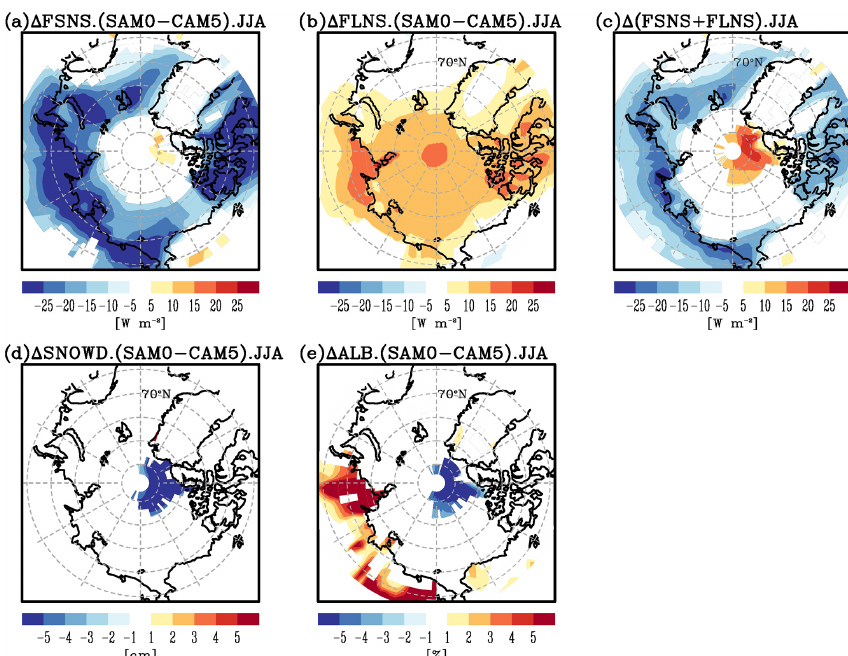
Figure 11. Differences of (a) net SW flux at the surface (FSNS), (b) net LW flux at the surface (FLNS), (c) sum of FSNS and FLNS, (d) snow depth (SNOWD), and (e) surface albedo (ALB) during JJA between SAM0 and CAM5. Shaded areas exceed the 95% significance level from the Student t